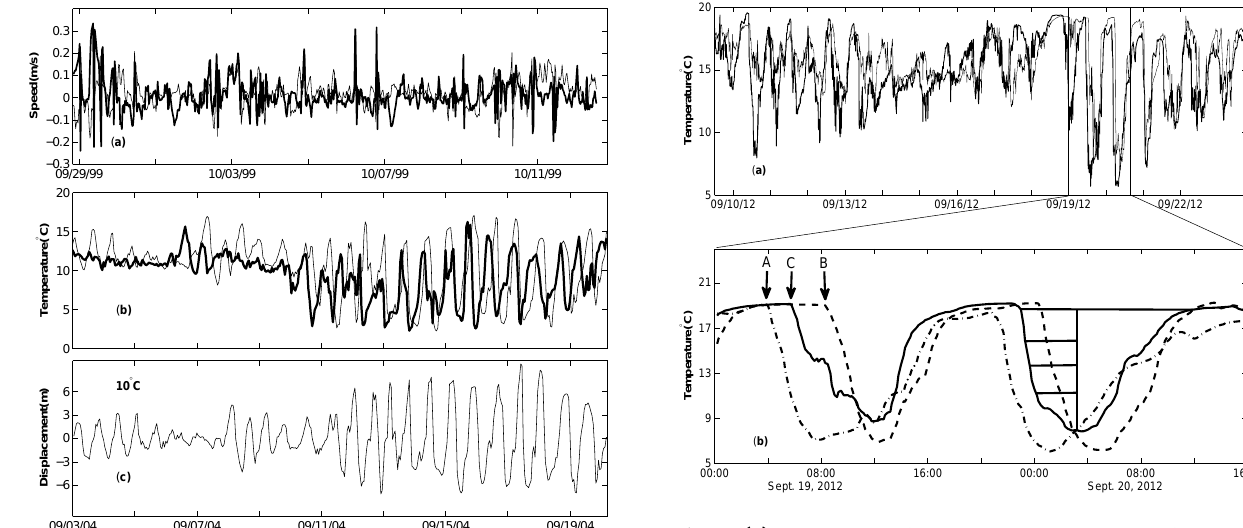
Fig. 3. (a) Time series of the temperature variations from the A mooring (bold curve) and B mooring (light curve) smoothed us- ing a Tukey window with a width of 1/3h are shown in Septem- ber 2012. (b) Time series of the temperature variations from the A mooring (dash-dot line), B mooring (dashed line) and C mooring (solid line) smoothed using a Tukey window with a width of 3h are shown during the temperature front propagation in September 2012. Asymmetry between the phase of the temperature increase and that of the temperature decrease is clearly